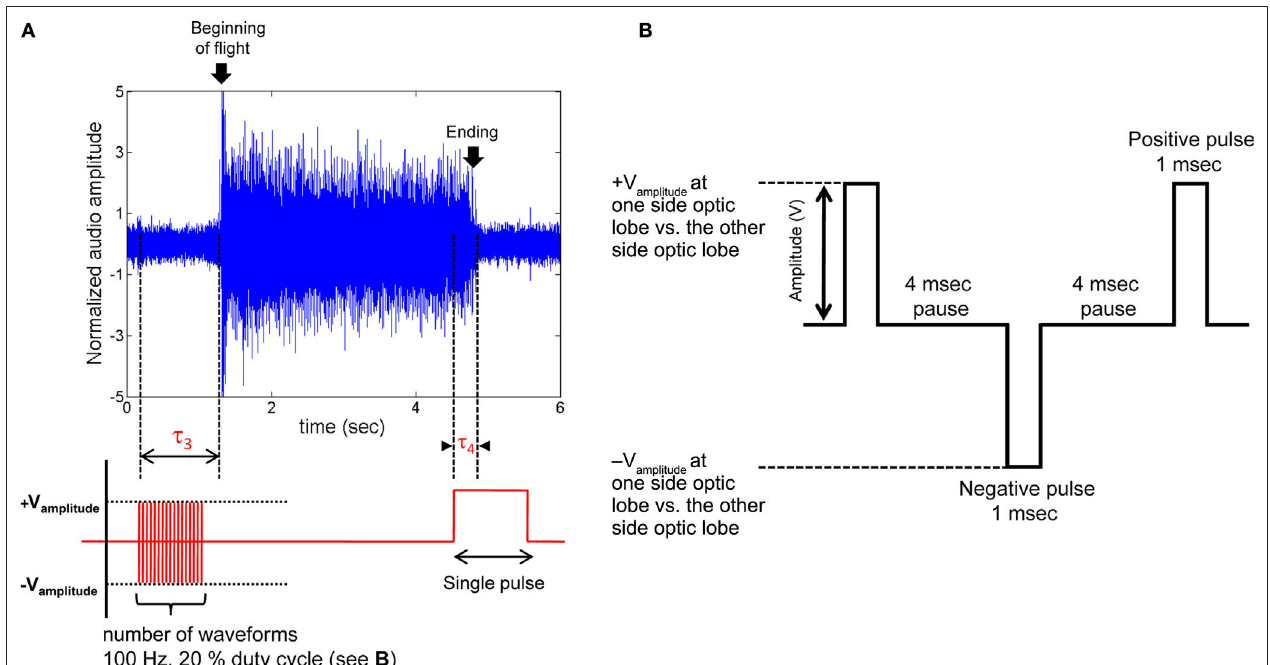
beginning of oscillation was attributed to friction between elytra and wings when the wings were unfolded from the underneath of elytra. The whole audio amplitudes were normalized using mean absolute value calculated for the middle period of the flight time (2.5–3.7 s). (B) Pulse trains applied between left and right optic lobes. Number of waveforms was swept from 1 to 100 in one waveform increment when testing for the number of waveforms required to trigger flight initiation (Table 2 in Supplementary Material). See Movies 5–7 in Supplementary Material for flight initiation and cessation control of fully tethered (Movie 5) and fully untethered (wireless communication, Movies 6 and 7) Mecynorrhina torquata